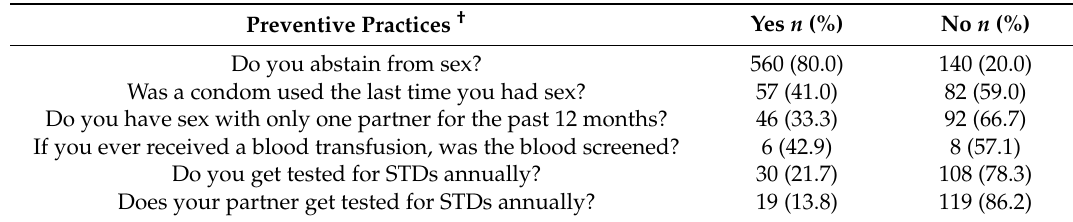
Table 3. Preventive practices on sexually-transmitted diseases among university students.